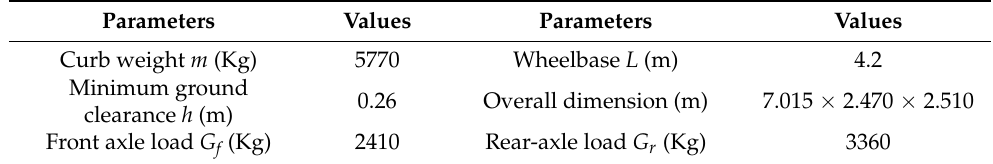
Table 1. Some vehicle parameters of the selected model. Parameters Values Parameters Values Curb weight m (Kg)